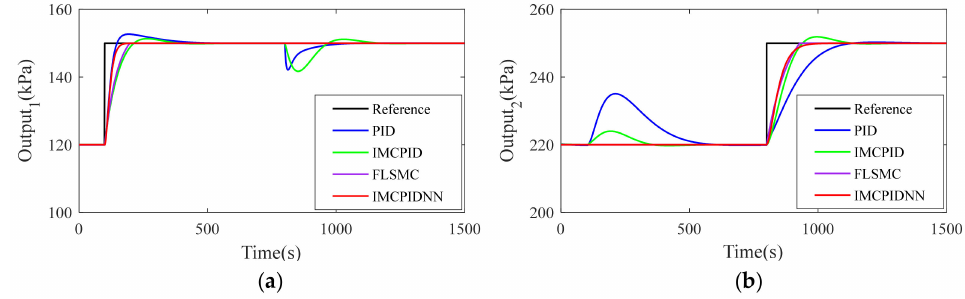
Figure 7. Comparison of step responses with sequential changes in set-points: ( a ) Output1; ( b ) Output2. The performance comparison of the four algorithms used for sequential step responses are presented in Table 4. For loop 1 and 2, the settle times t s obtained using the proposed controller are 61.91 s and 146.78 s respectively, and the overshoots M p are both zero. Mean- while, the results of the smallest four error evaluation indexes obtained by the IMCPIDNN controller can ensure the set-point tracking accuracy. Obviously, the IMCPIDNN controller performs better in terms of facing the interactions. Table 4. Performance comparison of the four algorithms used for sequential step